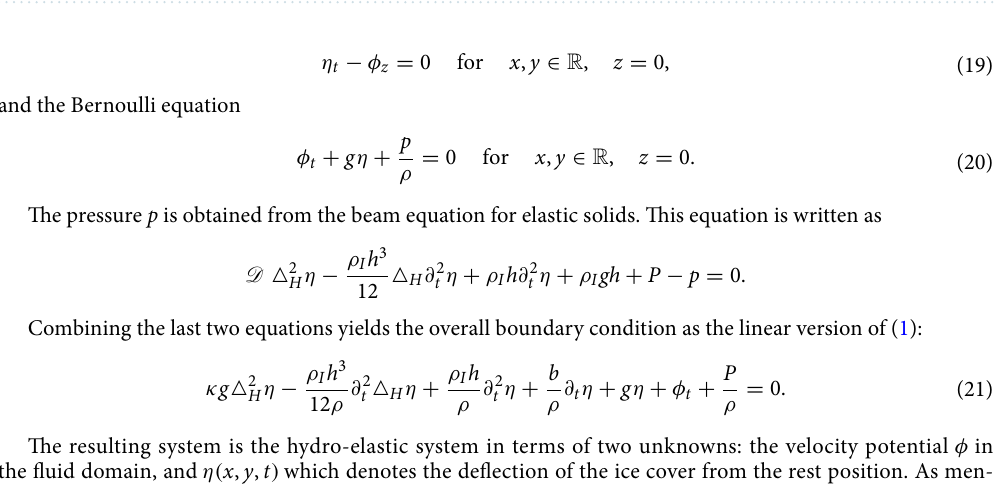
Figure 7. The phase speed c of a free wave plotted against the wavenumber k according to the dispersion 6.8 m, the thickness of the ice sheet is relation (22). The parameters are the same as in Fig. 1: the depth is H = h 0.17 m, the Young modulus is E 5.1 10 8 N/m 2 , the fluid density is 1026 kg/m 3 , and the ice density is = = × 3 917 kg/m . Axis units are [ m / s ] for vertical axis and [1/ m ] for horizontal